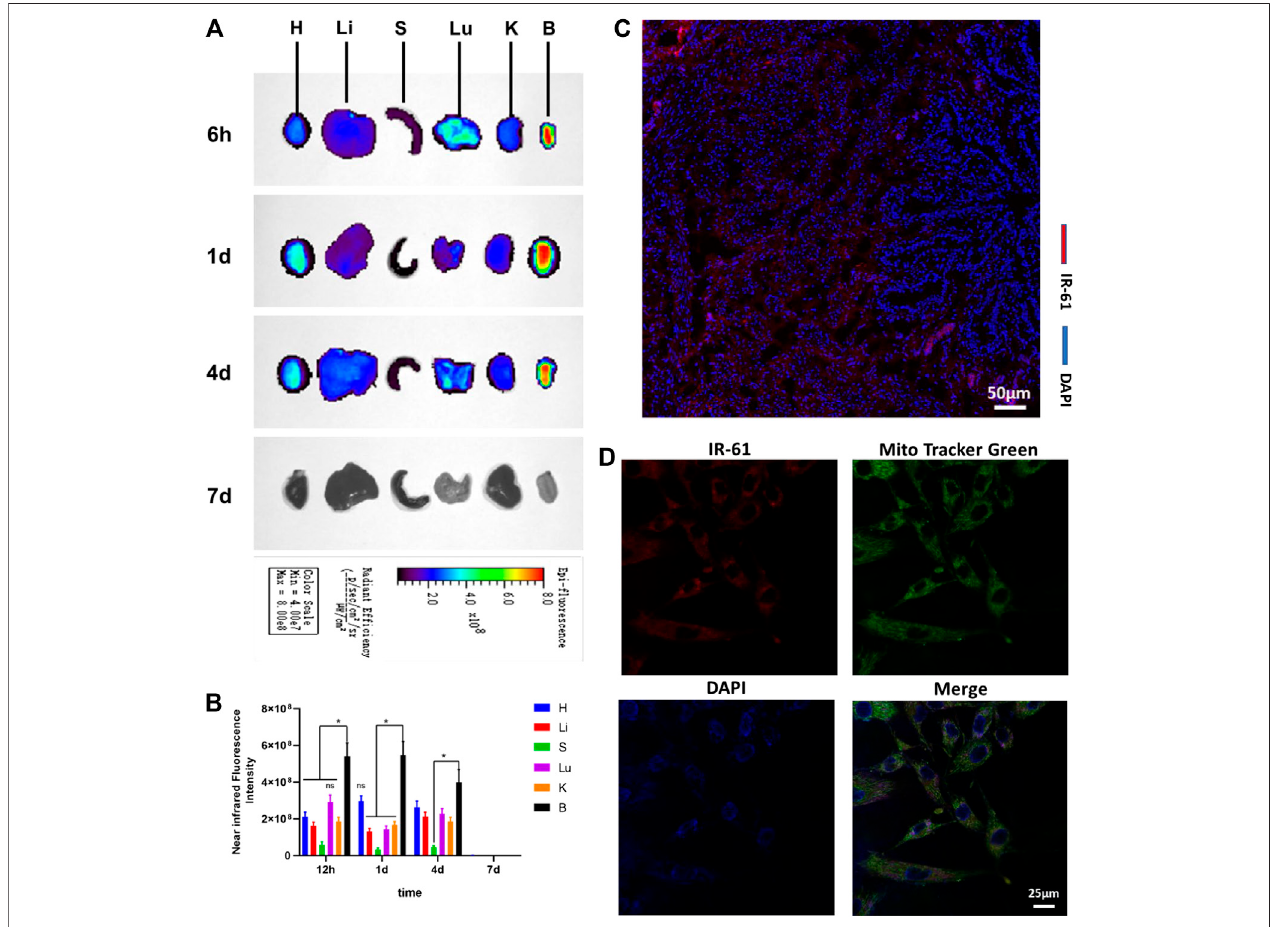
FIGURE 1 | Biodistribution and subcellular localization of IR-61. (A) Ex vivo NIR imaging of vital rat organs 6 h, 1 days, 4 days and 7 days after intraperitoneal injection. H, heart; Li, liver; S, spleen; Lu, lung; K, kidney; B, bladder. (B) Quantitative analysis of NIR fl uorescence intensities of vital organs at the indicated time points. (C) Fluorescence imaging of IR-61 (red) in bladder tissues, scale bar (cid:2) 50 μ m. (D) Determining the mitochondrial targeting of IR-61 in BSMCs by costaining with IR-61 and Mito-Tracker Green. Scale bar (cid:2) 25 μ m * p < 0.05 vs. NIR fl uorescence intensities of the bladder.